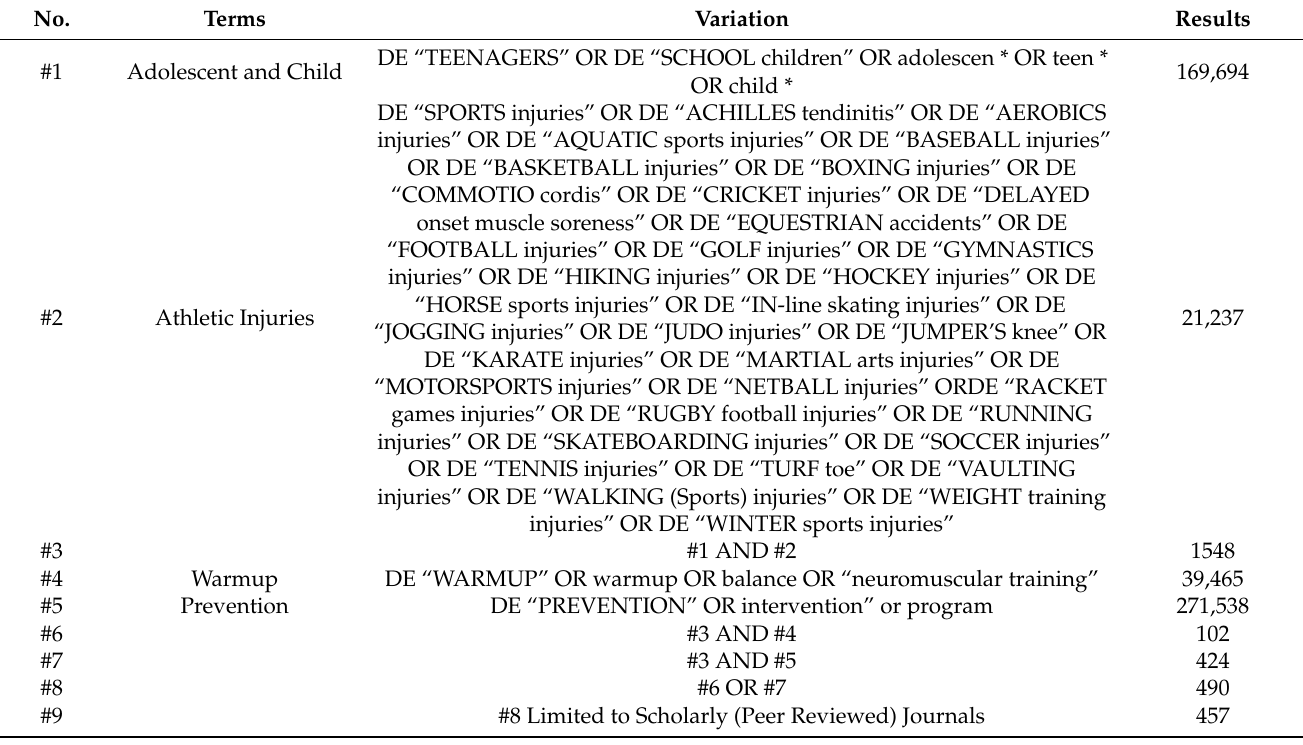
Table A6. SportDiscus Search Terms and Variations Used for Systematic